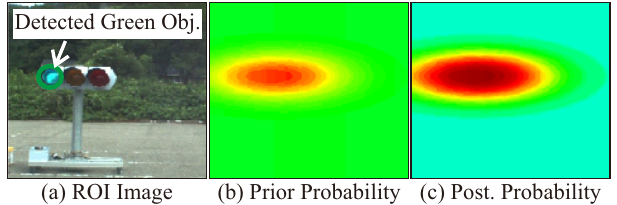
Figure 8. Probability updating.